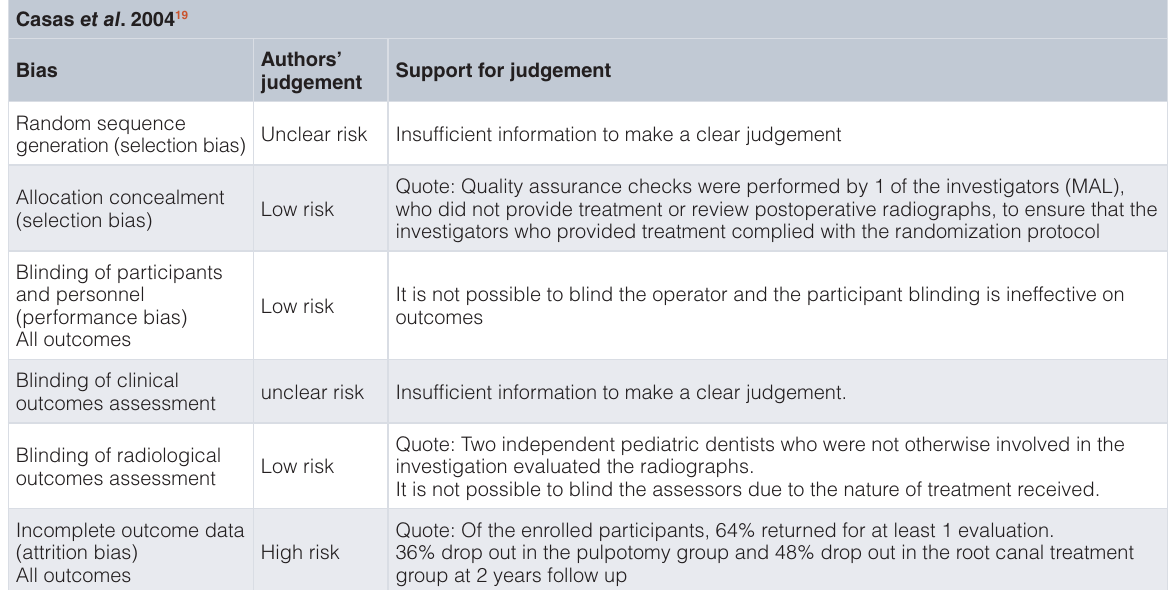
Table 7. Risk of bias in Casas et al . 2004.